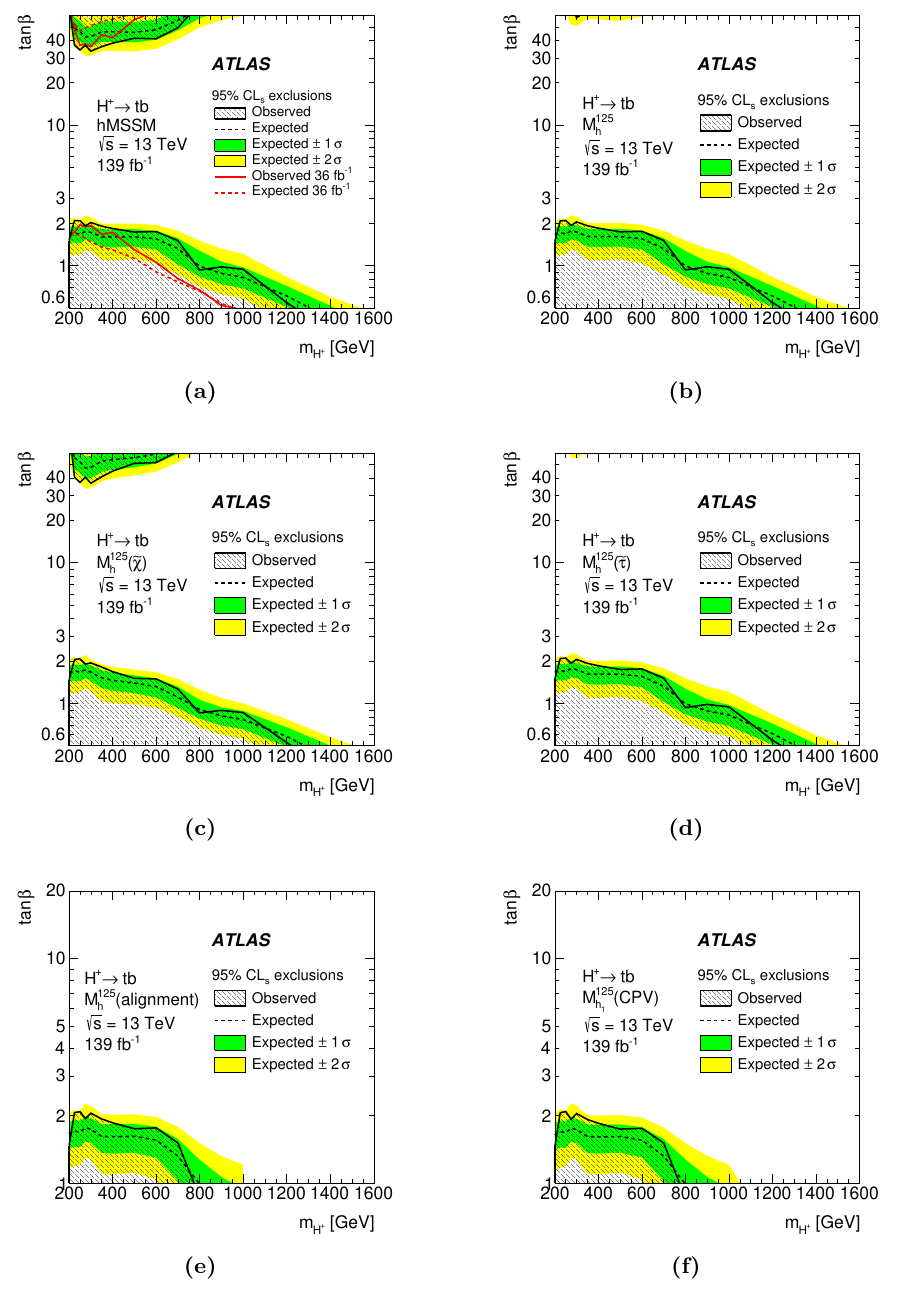
in various scenarios: (a) Figure 7 . Observed and expected limits on tan β as a function of m H + hMSSM, (b) M 125 , (c) M 125 (˜ χ ) , (d) M 125 (˜ τ ) , (e) M 125 (alignment) and (f) M 125 (CPV). Limits h h h h h 1 are shown for tan β values in the range of 0.5–60 or 1–20 depending on the availability of model predictions. The bands surrounding the expected limits show the 68% and 95% confidence intervals. Uncertainties in the predicted H + cross-sections or branching ratios are not